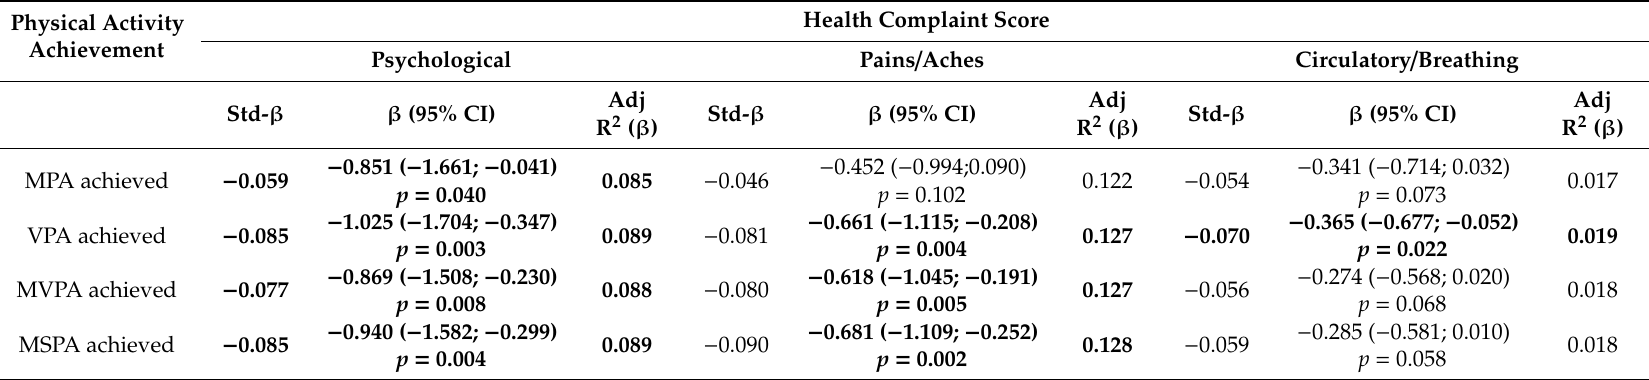
Table 7. Achievement of four physical activity guidelines as independent factors associated with self-reported health complaint scores among undergraduates, University of Turku, Finland